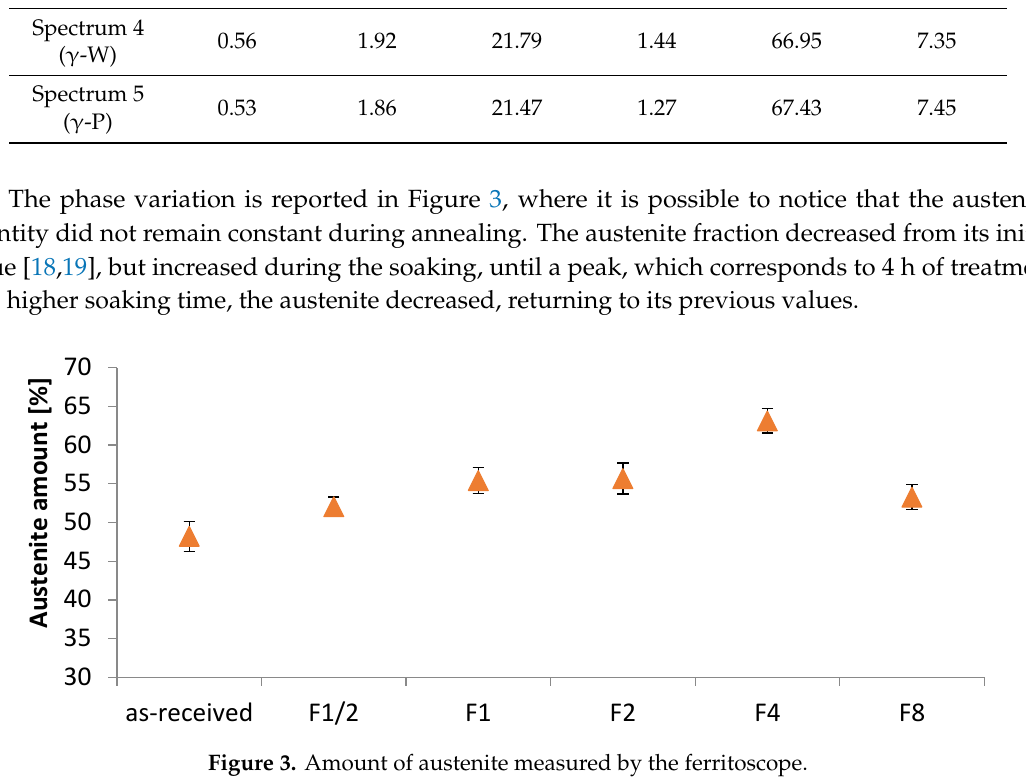
Figure 3. Amount of austenite measured by the ferritoscope.